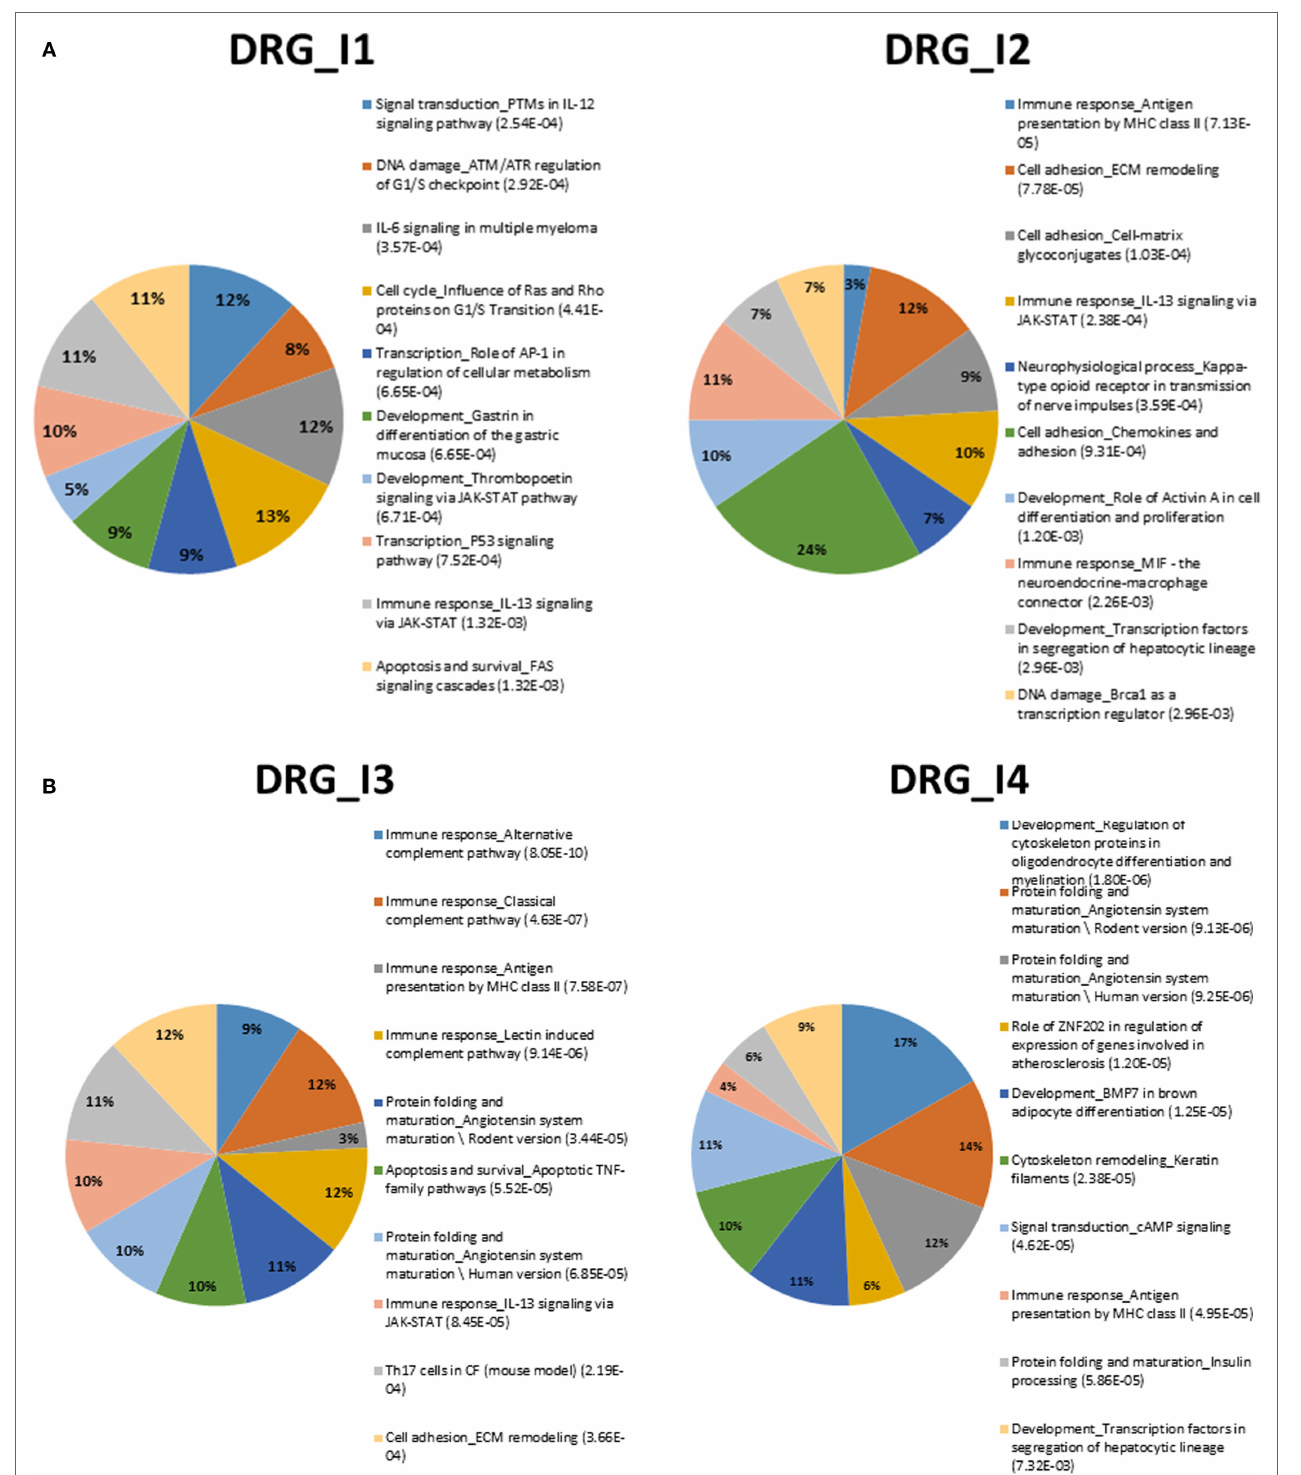
FigUre 2 | (a) Summary of top-10 pathways in DRG_I1 (left) and DRG_I2 (right). Percentage inside the pies represents enriched genes. FDR-corrected enrichment values are reported with listed pathway terms. (B) Summary of top-10 pathways in DRG_I3 (left) and DRG_I4 (right). Percentage inside the pies represents enriched genes. FDR-corrected enrichment values are reported with listed pathway